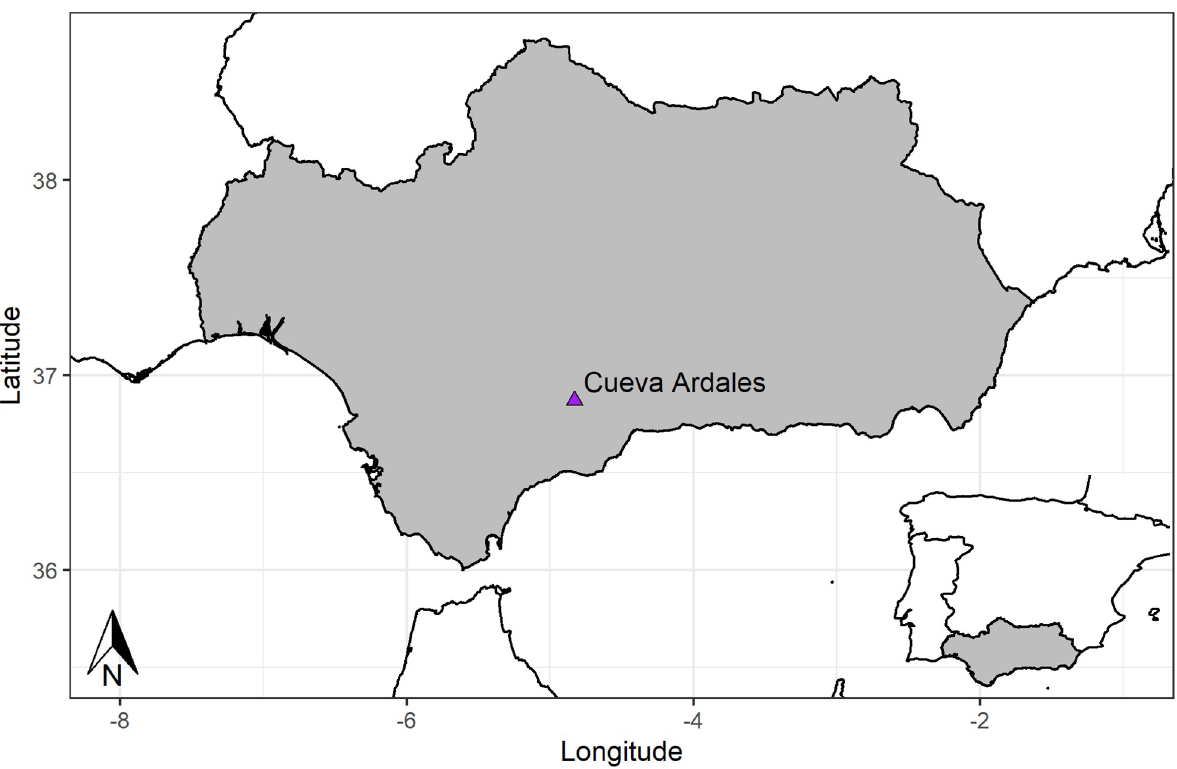
Fig 1. Geographical position of Ardales on the Iberian Peninsula. In grey Region Autonoma de